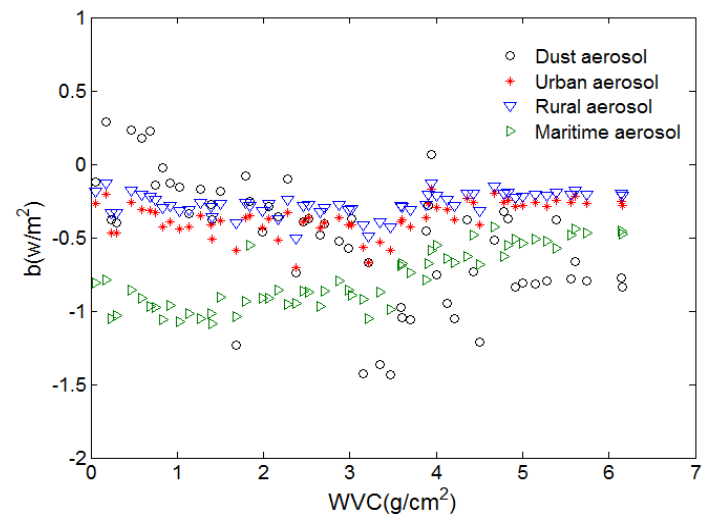
Figure 5. Scattering diagram of offset b in Equation (5) as a function of atmosphere water vapor content (WVC).